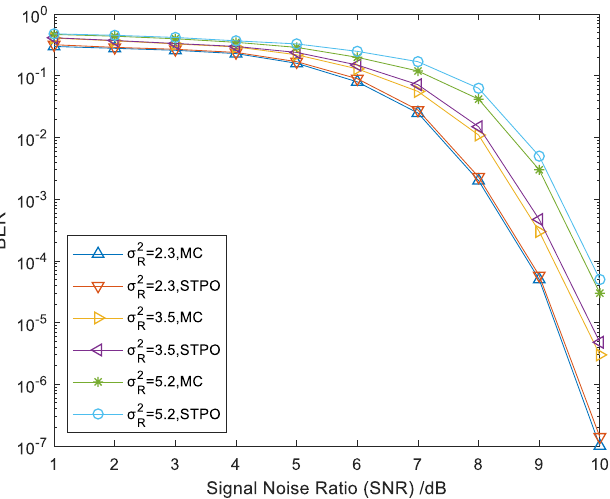
Figure 8. Comparison of bit error rate under different turbulence intensities.